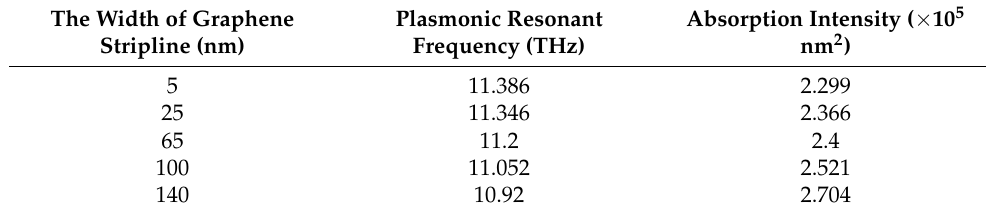
Table 4. Variations of absorption characteristics due to stripline’s width manipulations.